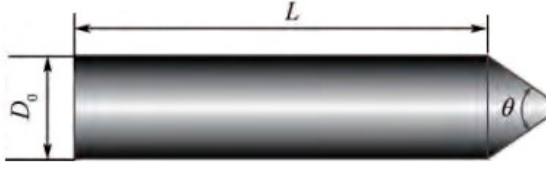
Figure 3. Water-entry object.